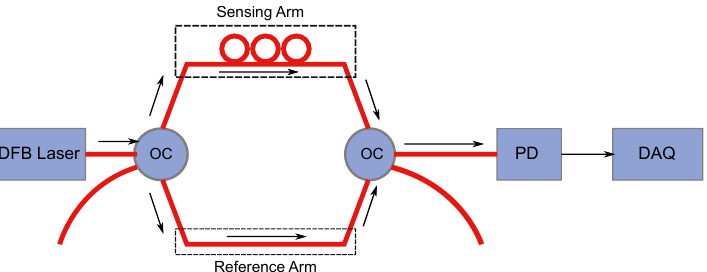
Figure 6. Schematic of a simple Mach–Zehnder Interferometer (MZI)-based detection system. DFB-Laser: Distributed Feedback-Laser, PC: Polarization Controller, OC: Optical Coupler, PD: Photodiode, and DAQ: Data Acquisition. (Adapted from [25].)